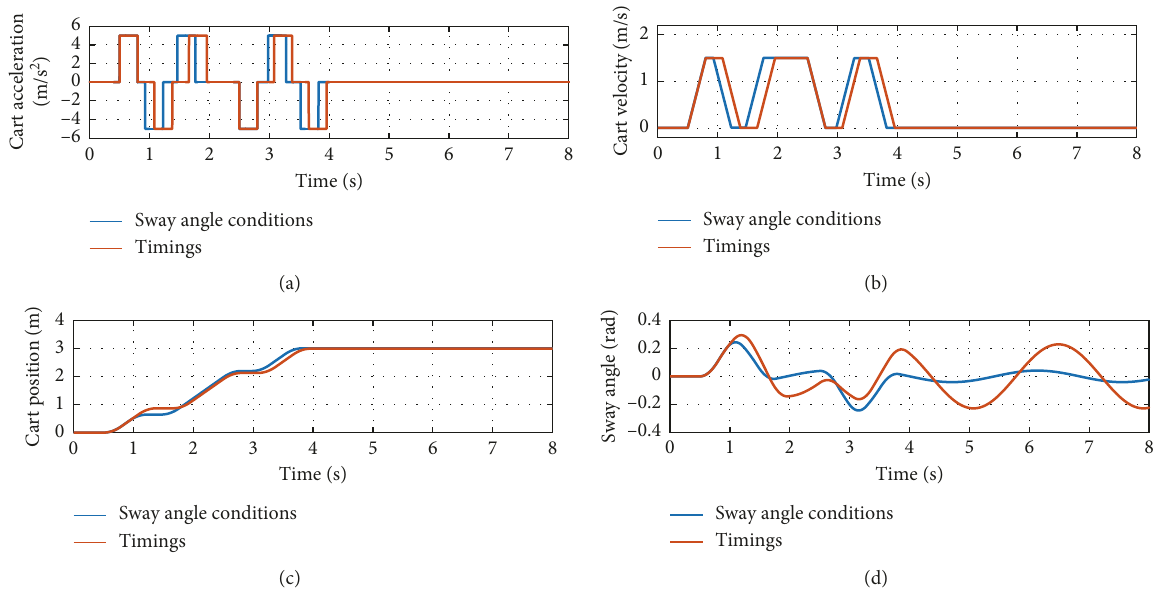
Figure 6: Simulation results of cart motion and load sway in overhead traveling crane with proposed and conventional operational methods, which have error between standard and practical rope lengths as l st position. (d) Angle of load sway. The blue lines represent the simulation results by operating the momentary switch based on sway angle conditions proposed in this study. The red lines represent the simulation results by operating the momentary switch based on timings reported in the conventional approach.